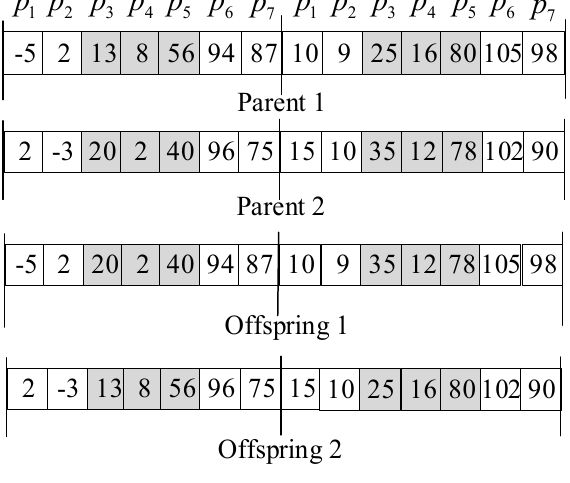
Figure 6. Two-point crossover example.